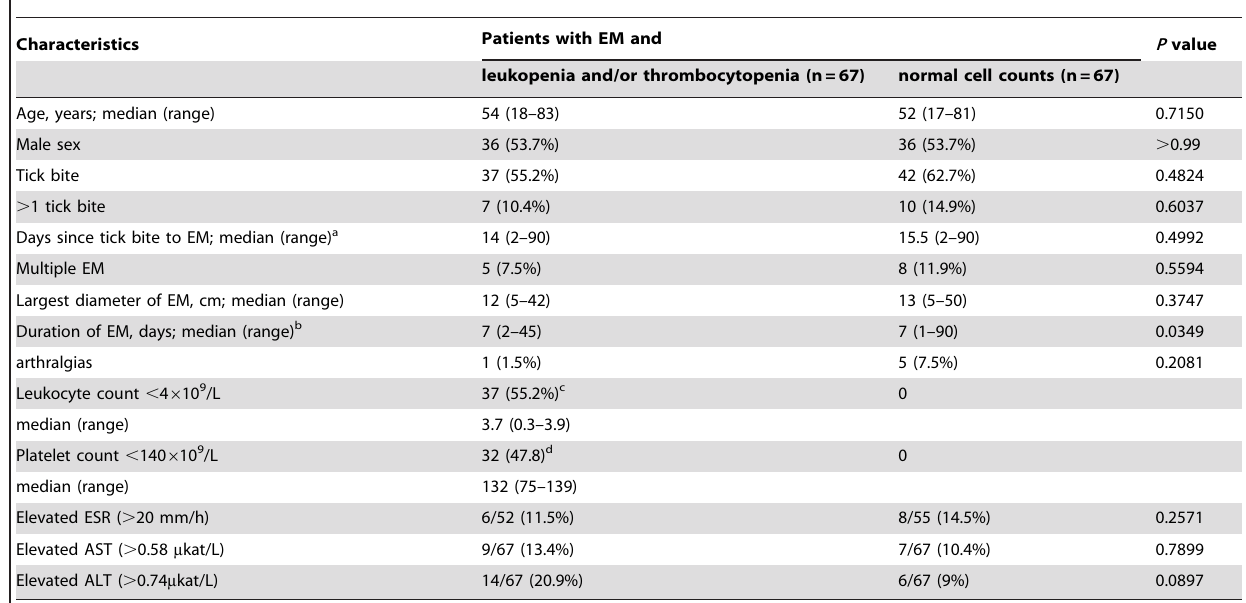
Table 1. Characteristics of patients with erythema migrans (EM) with associated leukopenia and/or thrombocytopenia, and patients with EM with normal blood cell count